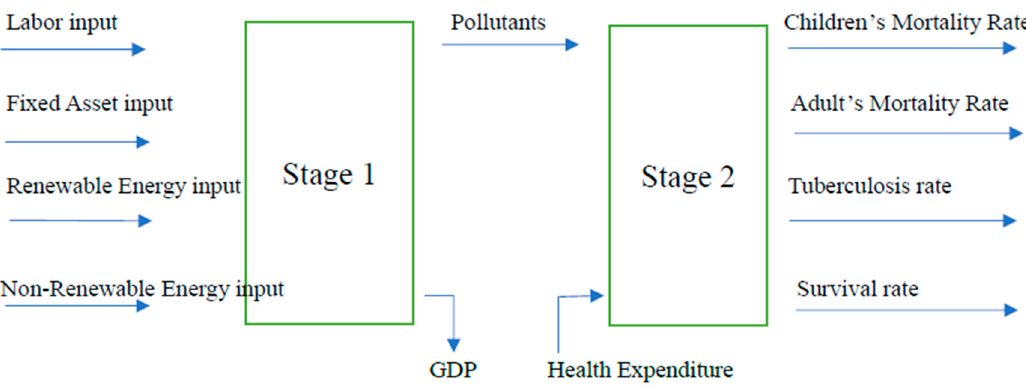
Figure 1. Process of inputs and outputs in production and health treatment stage.